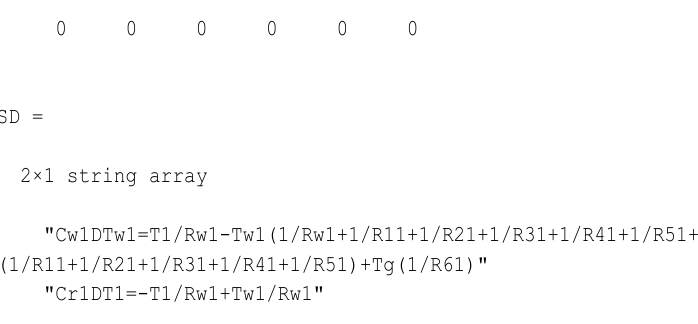
>> Figure A3. Case 1: Mathematical model for a single thermal